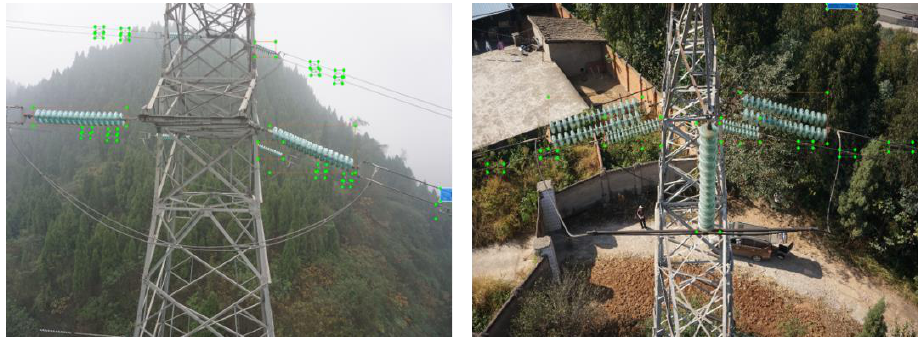
Figure 8. Example of annotation with LabelImg.